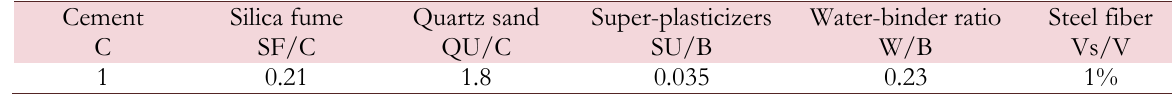
Table 1: Mix Ratios of RPC.